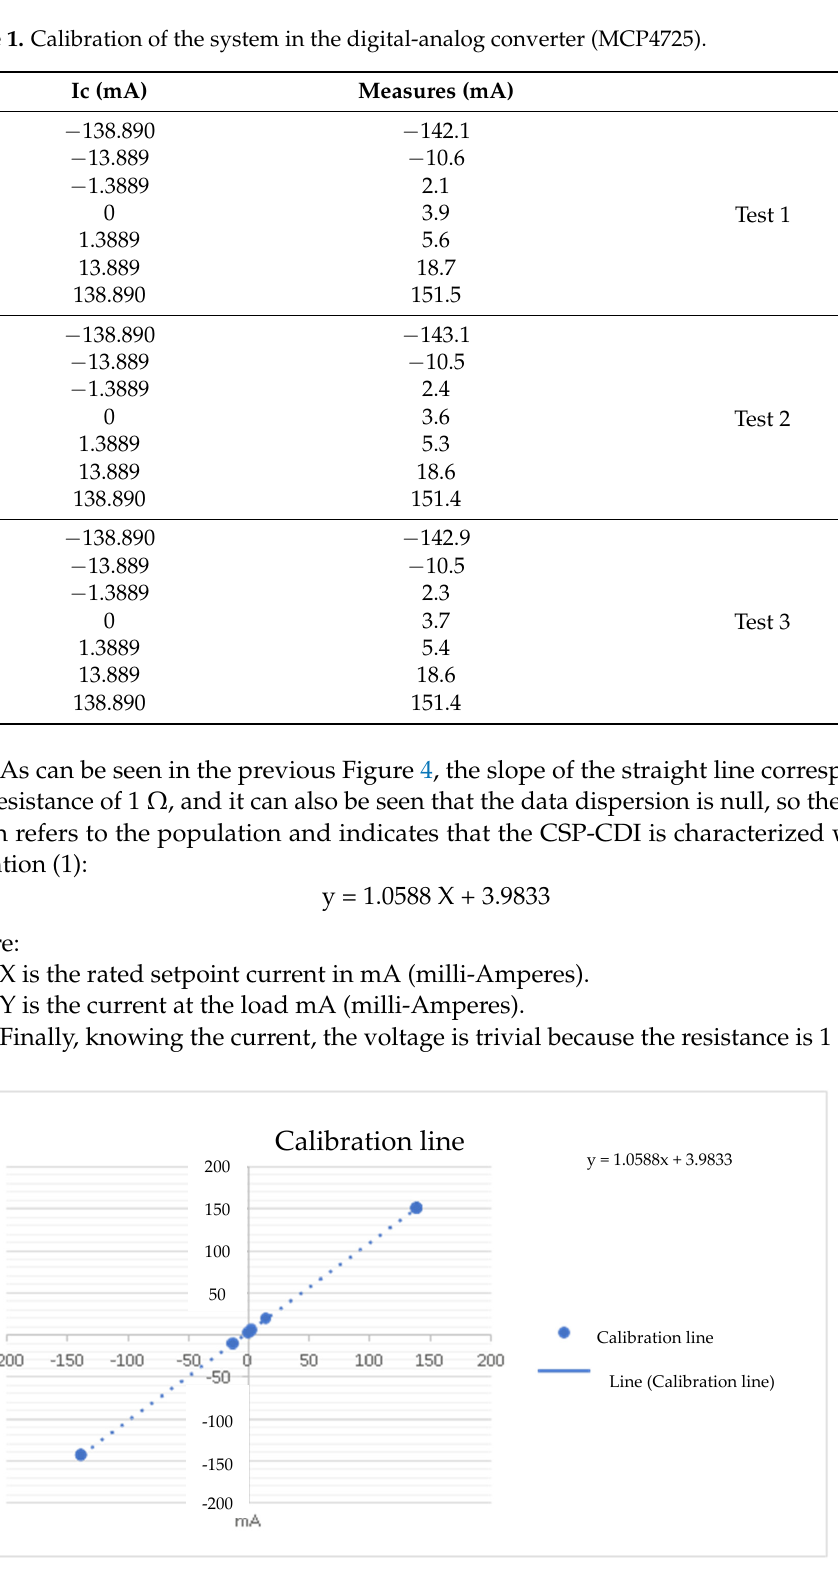
Figure 4. DAC calibration with the load resistance. Calibration of the Analogical-Digital Converter